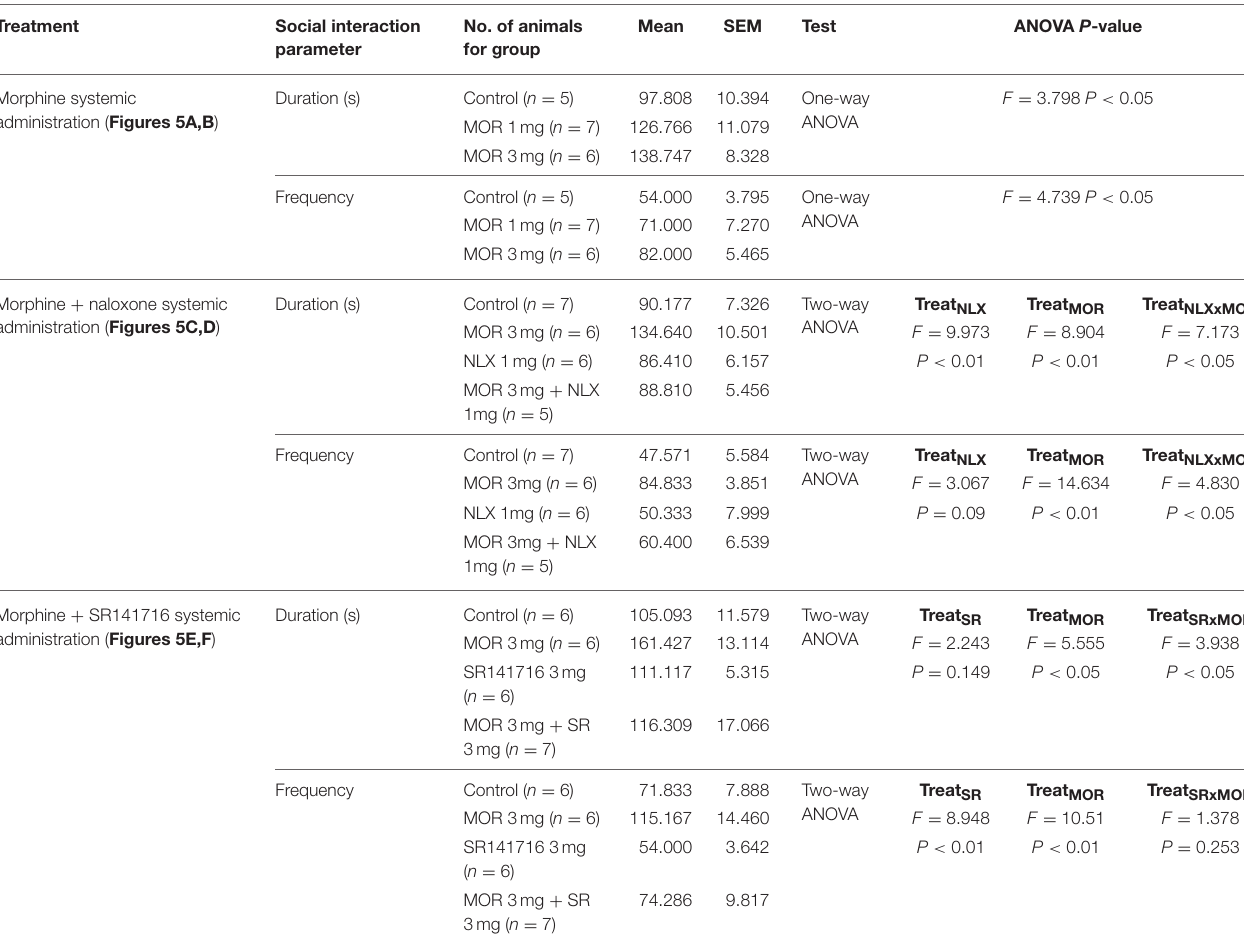
TABLE 4 | Statistical report of social behavior parameters in adolescent mice following systemic morphine. Treatment Social interaction No. of animals Mean SEM Test ANOVA P -value parameter for group Morphine systemic administration ( Figures 5A,B